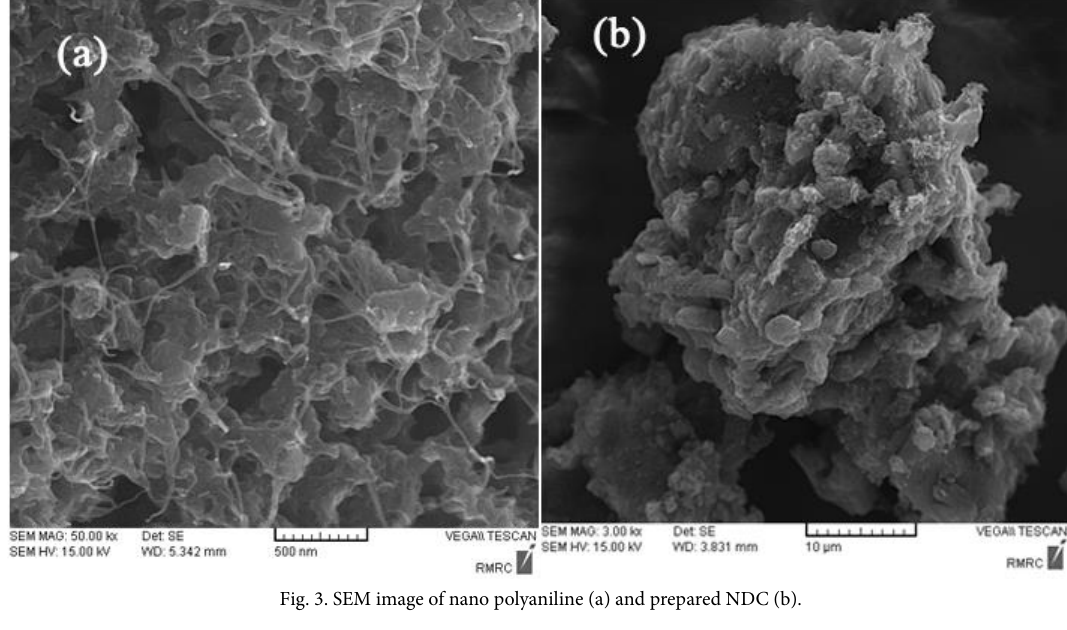
Fig. 3. SEM image of nano polyaniline (a) and prepared NDC (b). Fig.3. SEM image of nano polyaniline (a) and prepared NDC (b).